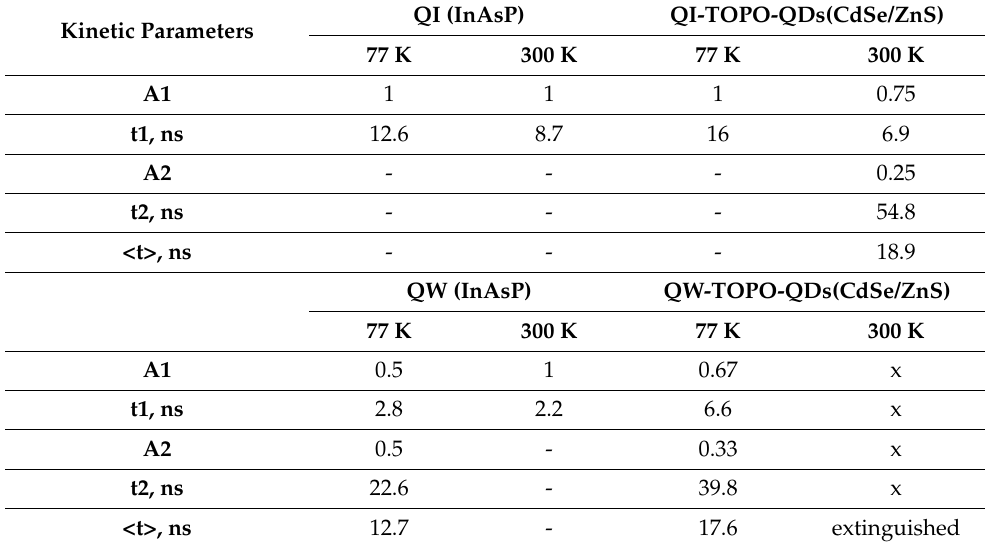
Table 2. The parameters of QI and QW kinetics at 532 nm wavelength excitation. Kinetic Parameters